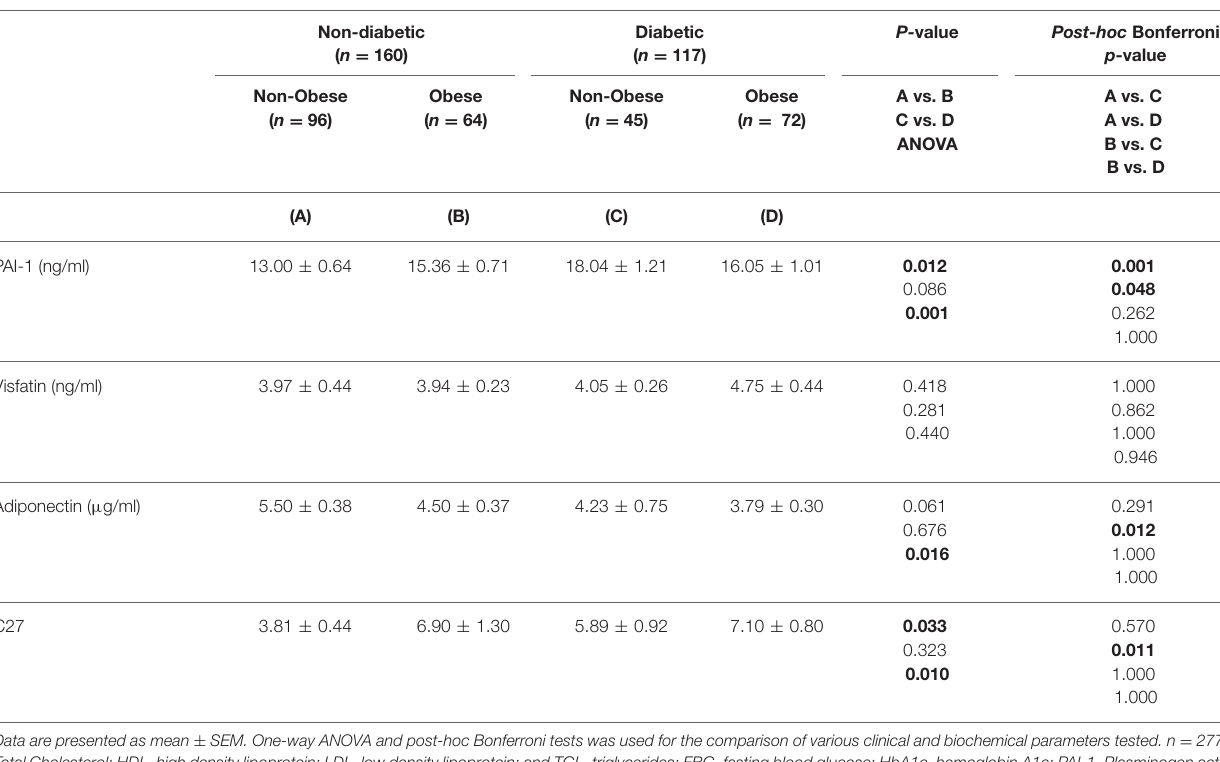
for age. As shown in Table 3 , among all the clinical parameters, significant positive correlation was observed between DNAJC27 level and FBG level ( r = 0.316, P = 0.009). There was a strong positive correlation of DNAJC27 level with HOMA-IR ( r = 0.316, P = 0.01). A positive correlation was also observed between TGL level and DNAJC27 ( r = 0.215, P =